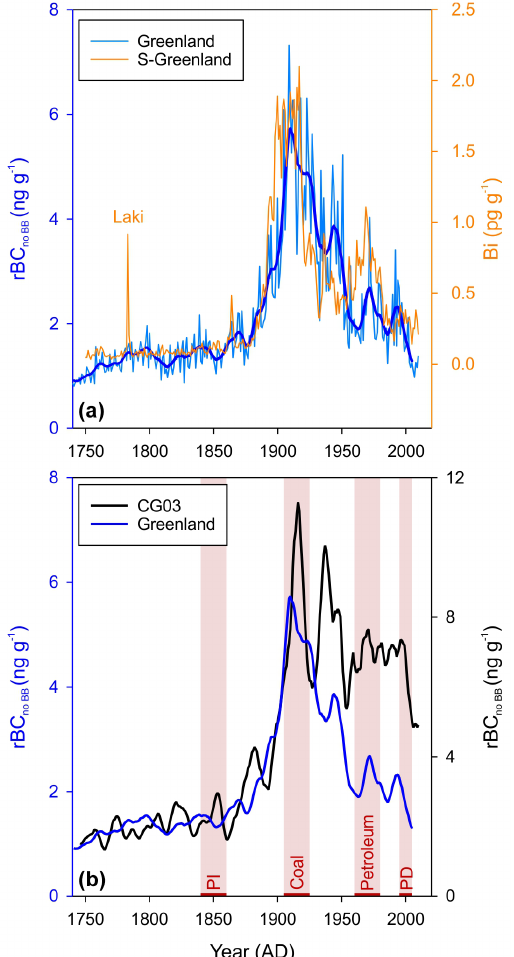
Figure 5. (a) Stacked rBC record from Greenland including the four ice cores NEEM-2011-S1, D4, TUNU2013, and Summit2010 (Kee- gan et al., 2014; McConnell et al., 2007; Mernild et al., 2015; Sigl et al., 2013, 2015) and (orange) a stacked Bi record from the South Greenland ice cores (Chellman et al., 2017) . Samples influenced by forest fire and biomass burning (BB) activity were replaced by the corresponding 21-year running median before smoothing the record with an 11-year filter (thick blue line). BB activity detection is based on co-registered vanillic acid (for D4; McConnell et al., 2007) and on an outlier detection algorithm previously employed for discrim- ination of fire activity and volcano detection in Greenland ice cores (Fischer et al., 2015; Sigl et al., 2013). (b) Stacked rBC no BB record from Greenland and CG03 no BB record. Mean rBC no BB concentra- tions and relative enrichment to pre-industrial (PI) are provided for specific age windows marked by red shading (summarized in Ta- ble 3) dominated by coal-burning, petroleum-product burning, and present day (PD)